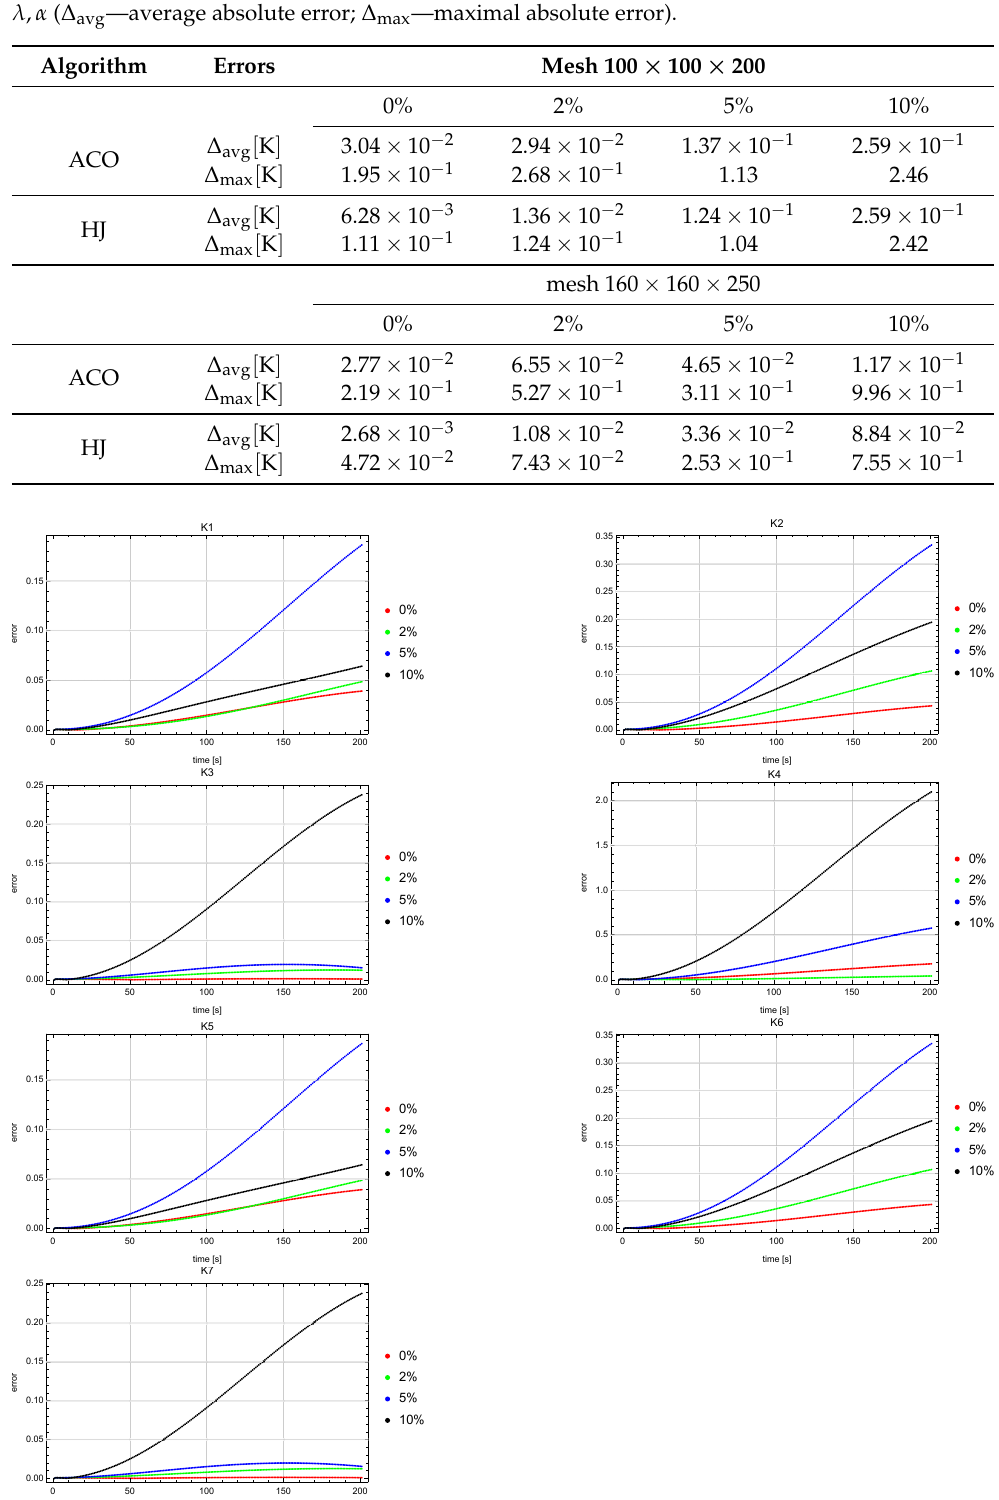
Figure 4. Errors of reconstruction of u state function in points K 1, K 2, K 3, K 4, K 5, K 6, K 7 for ACO